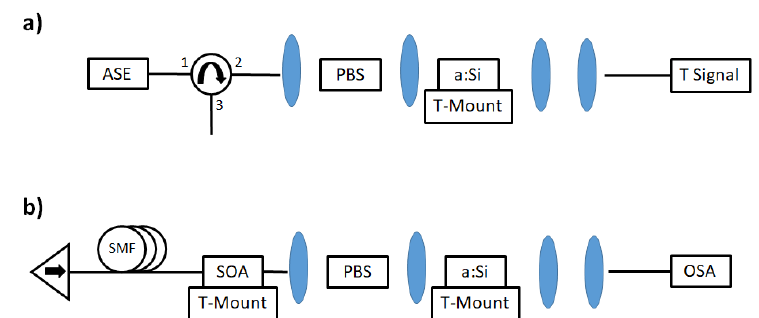
Figure 3. ( a ) End-fire set up used to characterize PhC cavity transmission and reflection spectra. ( b ) End-fire set up used to characterize operation of hybrid external cavity